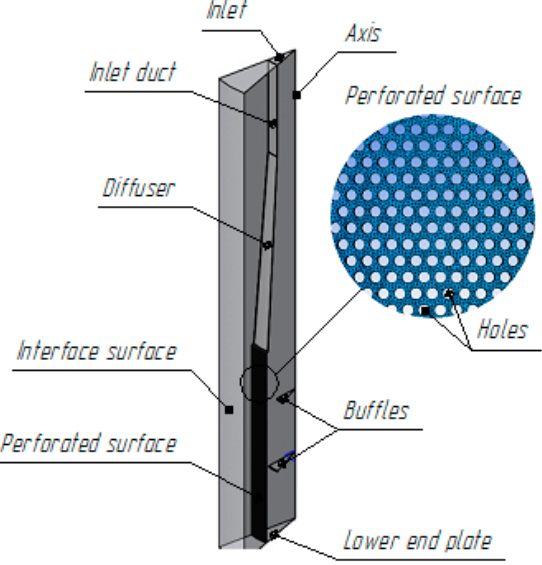
Figure 2. Design elements of the calculation model.